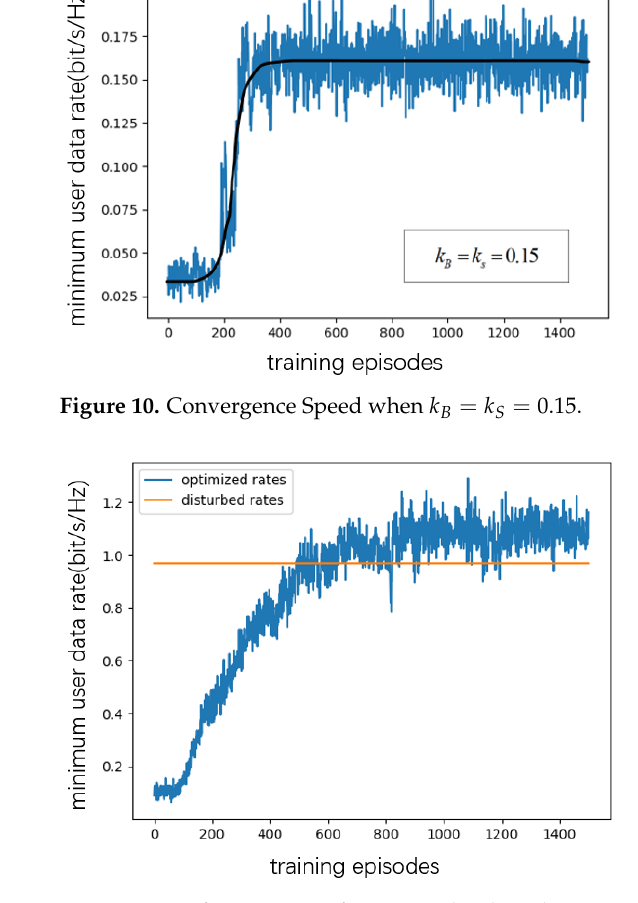
Figure 11. Performance verification under disturbance.